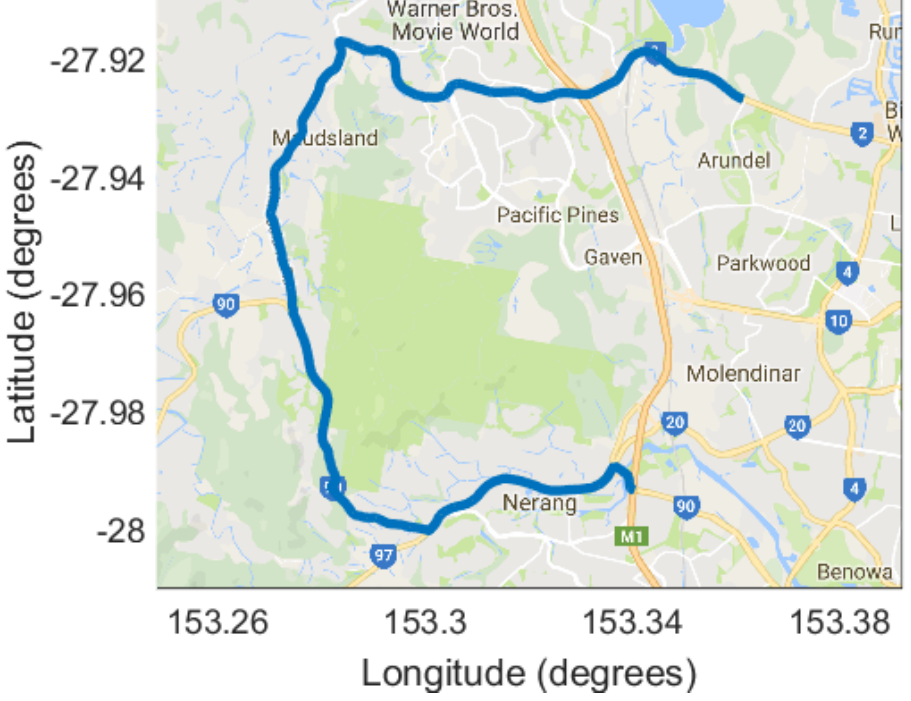
Figure 4. Rural section of the driving